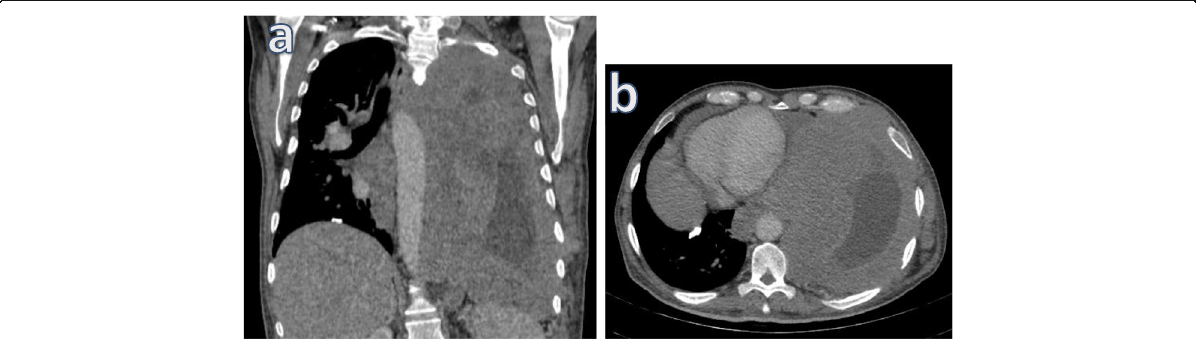
Fig. 4 A male patient 48 years old, a smoker with history of occupational exposure to asbestos for 31 years. ( a ) Coronal ( b ) axial mediastinal window contrast enhanced CT scan of the chest showing left sided mesothelioma in the form of non-uniform circumferential pleural thickening mounting to formation of pleural masses with left pleural effusion, total left lung collapse and contralateral mediastinal shift. Right diaphragmatic pleura calcified plaque is noted. Pericardial effusion and mediastinal lymphadenopathy are also noted.